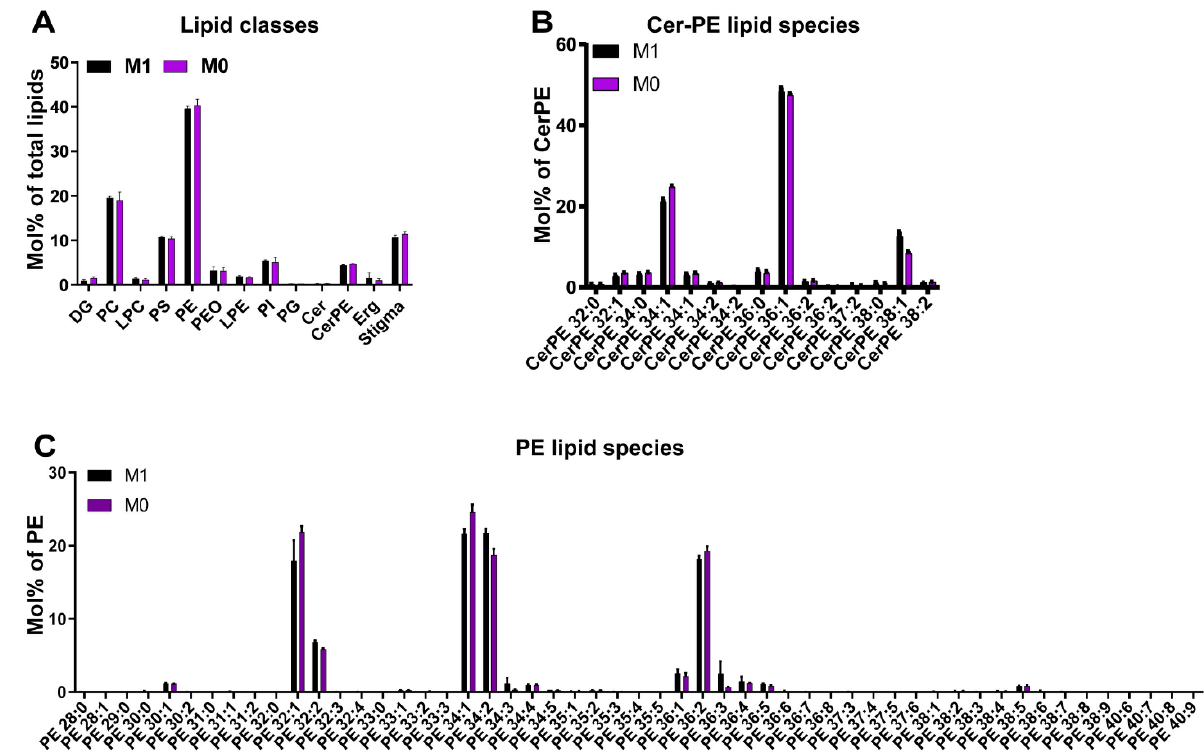
Figure 3. The eye lipidome of wild type Drosophila melanogaster raised on synthetic M1 diet (contains vitamin A precursor) or synthetic M0 diet (lacks vitamin A precursors). ( A ) Quantification (in mol%) of different lipid classes in the wild type Drosophila eye for M1 diet (control, black) and M0 diet (vitamin A deficiency, purple). ( B ) Analysis of ocular phospatidylethanolamine ceramide (Cer-PE) lipid species for M1 diet (black) and M0 diet (purple). ( C ) Analysis of ocular phospatidylethanolamine (PE) lipid species for M1 diet (black) and M0 diet (purple). Table 1. Pathways and their protein components that respond to vitamin A deficiency in the Drosophila eye. For details, see